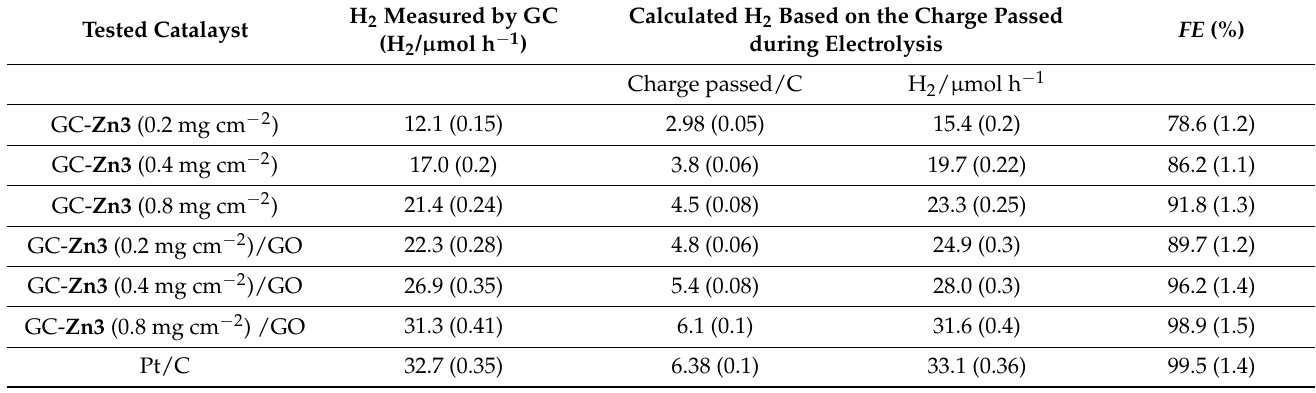
Table 6. Mean value (standard deviation) of V H2 (measured and calculated) obtained after 1 h of a controlled galvanostatic electrolysis (CGE) *, together with the Faradaic Efficiency values, FE (%), for the studied